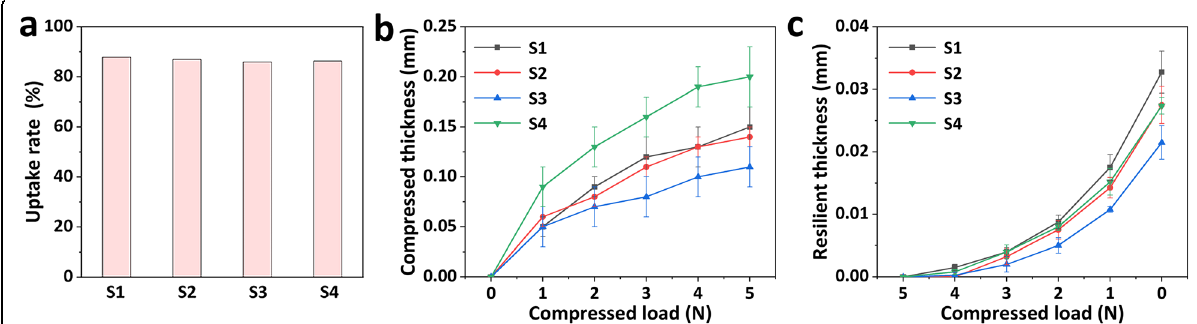
Fig. 7 Uptake rates of retanning agents in wet white ( a ); compression ( b ) and resilience ( c ) performance of crust